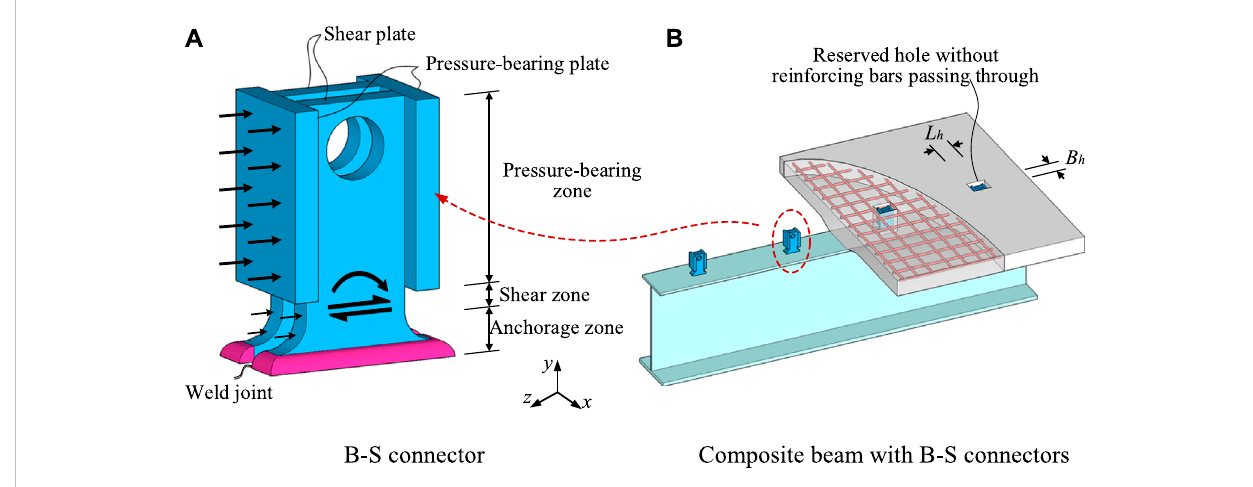
FIGURE 1 Steel-precast concrete slab composite beam structural system (Zou et al., 2021). (A) B-S connector. (B) Composite beam with B-S